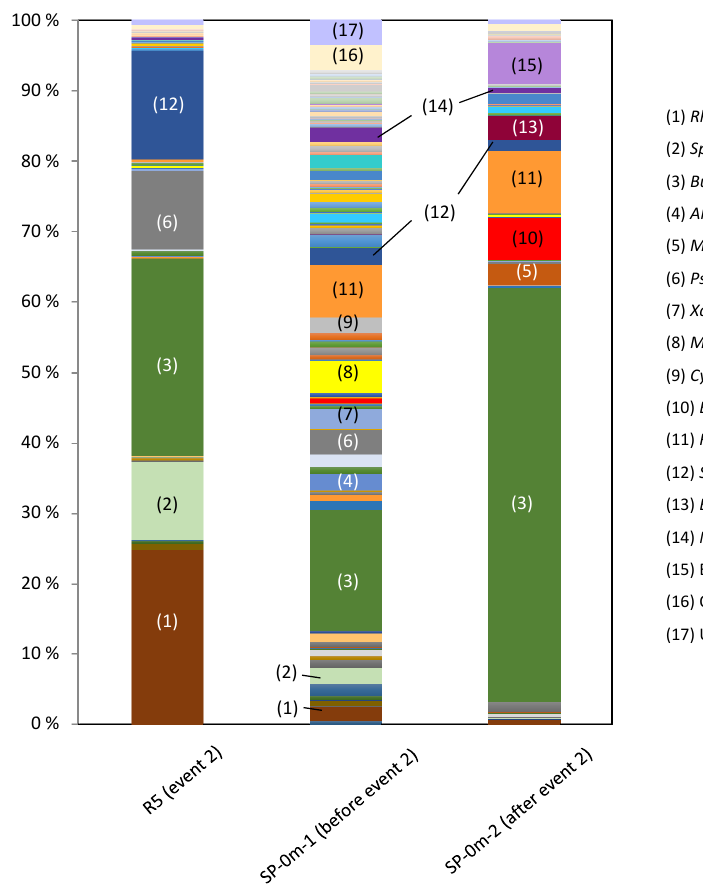
Figure 4. Relative abundance of bacterial orders in each event by next-generation sequencing